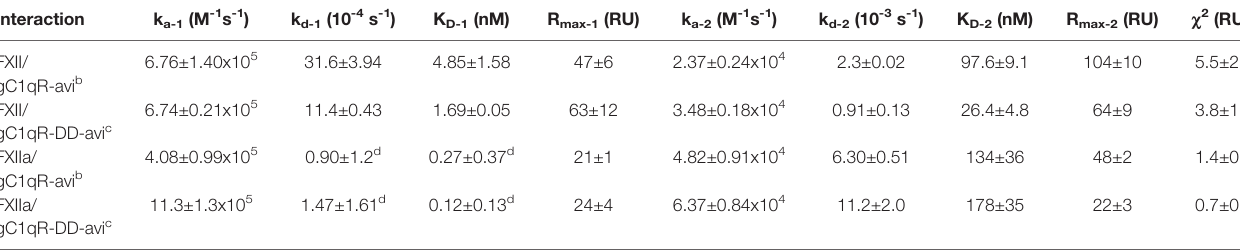
TABLE 2 | Interaction Parameters for FXII and FXIIa with Surface Captured gC1qR and gC1qR-DD a .